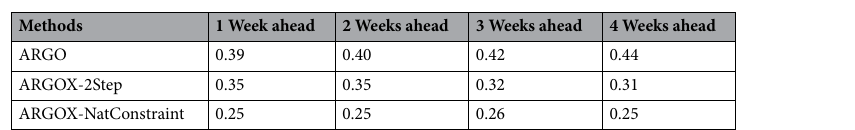
Table 3. Ensemble approach total selections across all 51 U.S. states for 1 to 4 weeks ahead predictions.